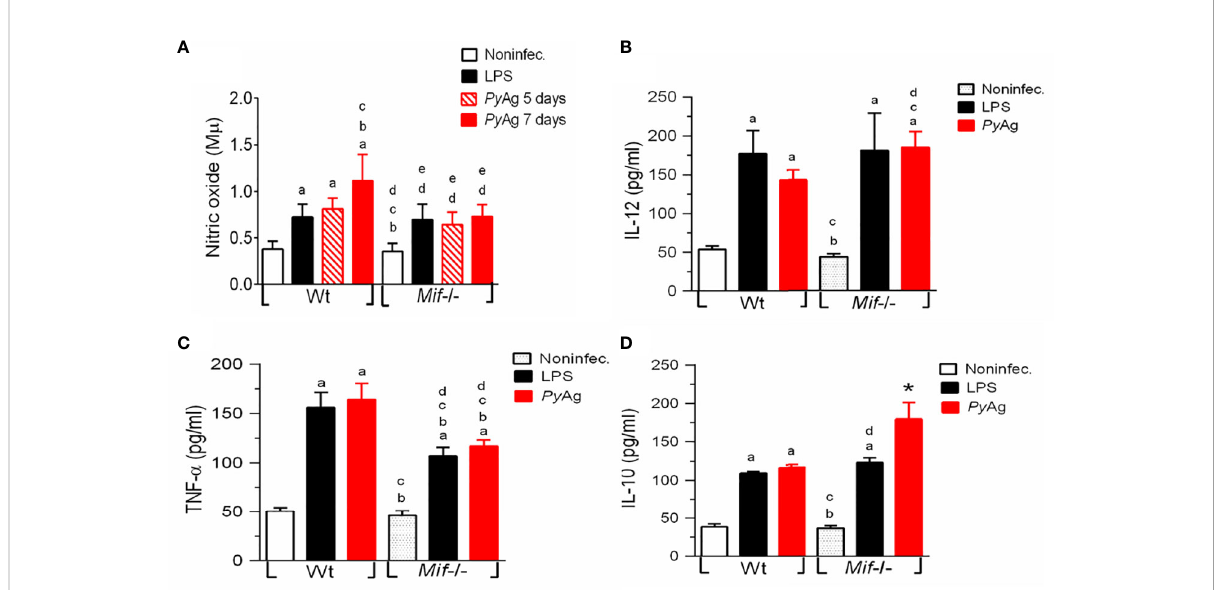
FIGURE 5 Mif -/- macrophages stimulated with Py Ag exhibited higher levels of IL-12 and IL-10 and decreases in TNF- a a and nitric oxide production during Py 17XL infection. Peritoneal M j s from Py 17XL-infected Wt and Mif -/- experimental groups were isolated at seven days postinfection and stimulated with Py Ag (25 µg/mL). (A) Nitric oxide, cytokines (B) IL-12, (C) TNF- a , and (D) IL-10 were measured in supernatants collected after 24 h. Data are expressed as the mean ± SEM and are representative of 3 independent experiments with 3- to 5 mice per group. Values of p < 0.05 were considered statistically signi fi cant, (a) compared with the noninfected group, (b) compared with the LPS WT group, (c) compared with the Py Ag Wt group, (d) compared with the noninfected Mif -/- group, and (*) compared with all experimental